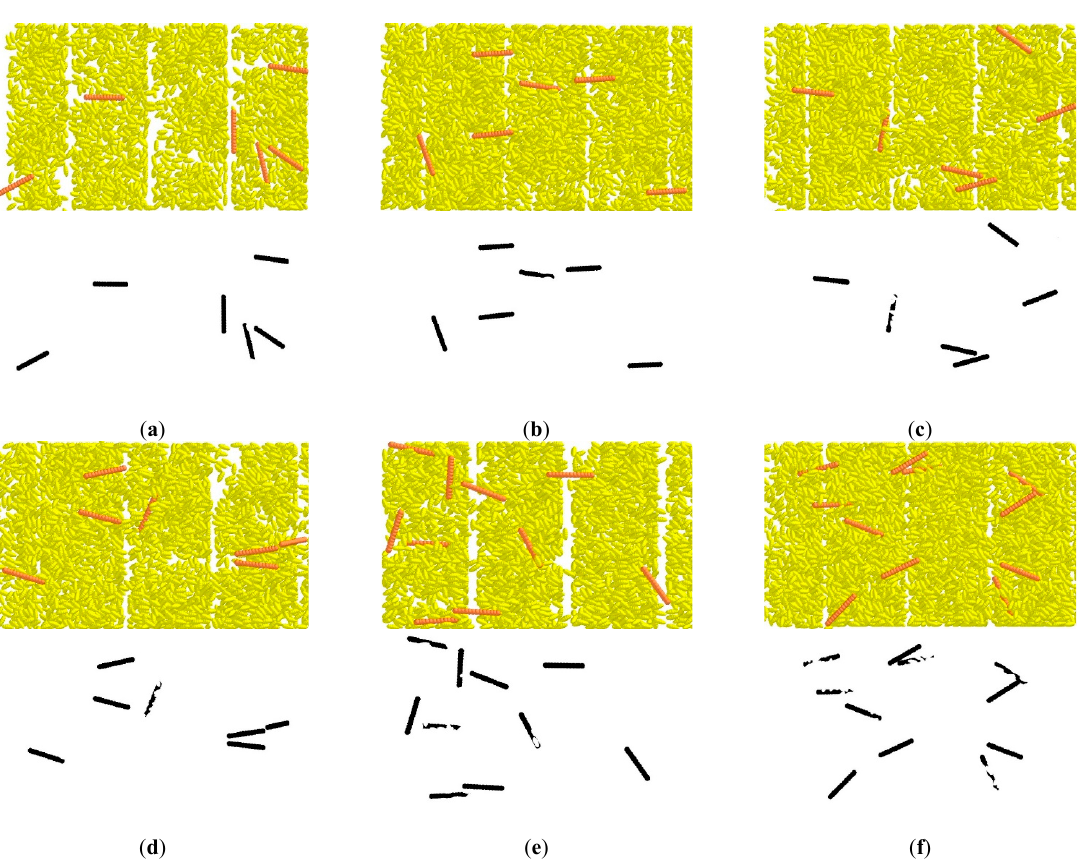
Figure 11. Impurity visualization analysis under different deflector gap. ( a ) d = 7.5 mm, S = 2.73%, ( b ) d = 10 mm, S = 3.75%, ( c ) d = 12.5 mm, S = 6.92%, ( d ) d = 15 mm, S = 9.54%, ( e ) d = 17.5 mm, S = 12.10%, ( f ) d = 20 mm, S = 18.11%.